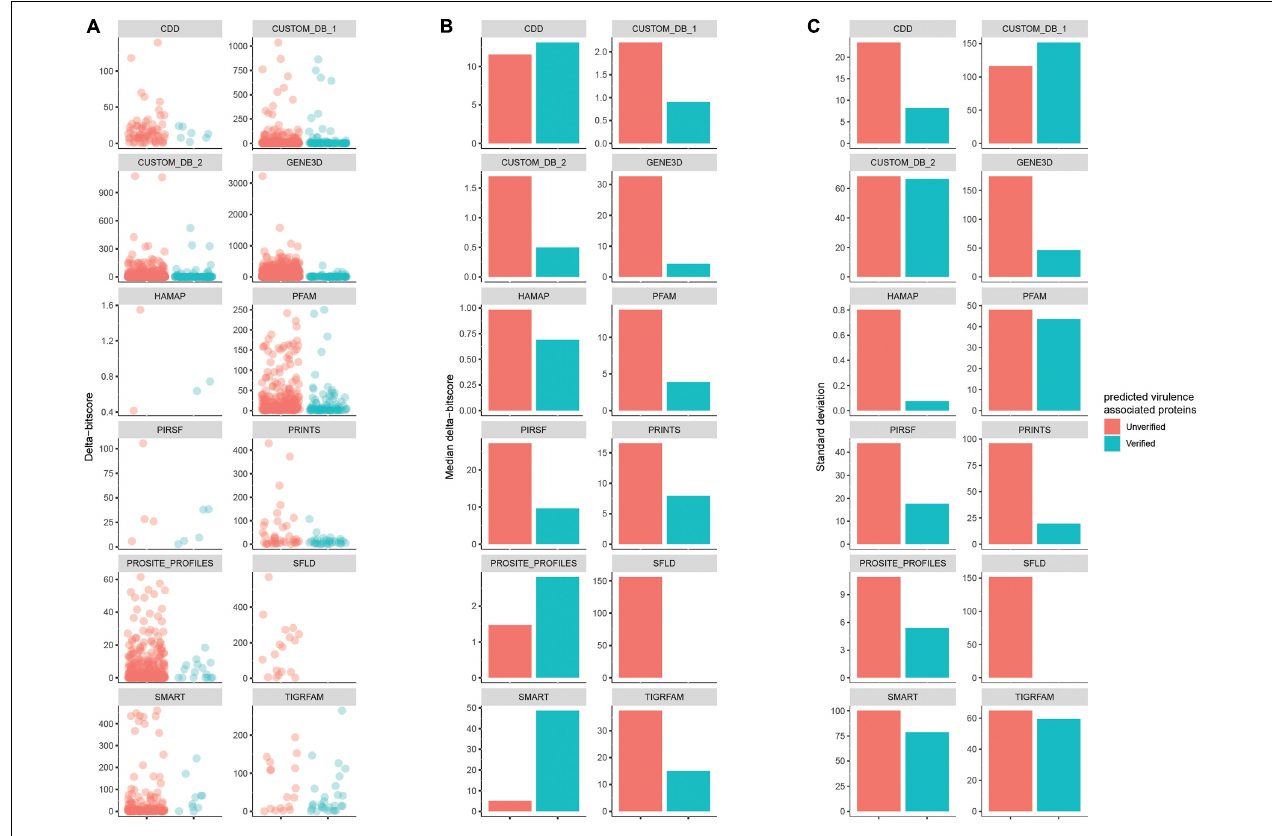
FIGURE 5 | Comparison of the delta-bitscore of predicted proteins depending on Seed_database divided into experimentally verified virulence associated proteins (red dots) and unverified ones (blue dots) (A) . The median of delta-bitscore results on the data are shown in (B) and the standard deviation of the results in (C) .